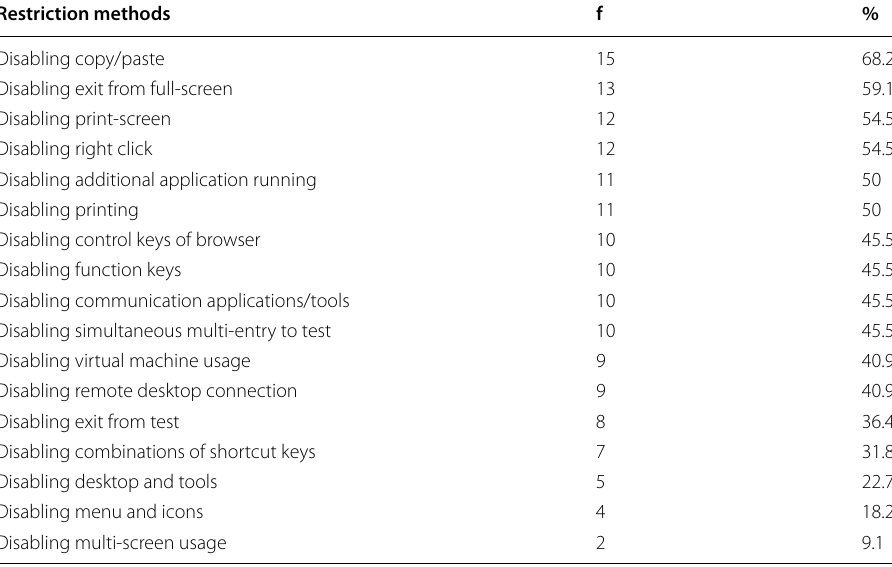
Table 5 Restriction methods used in online assessment systems Restriction